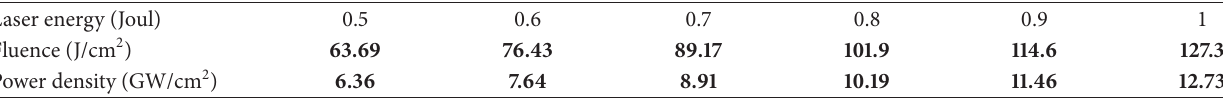
Table 1: Laser shock processing